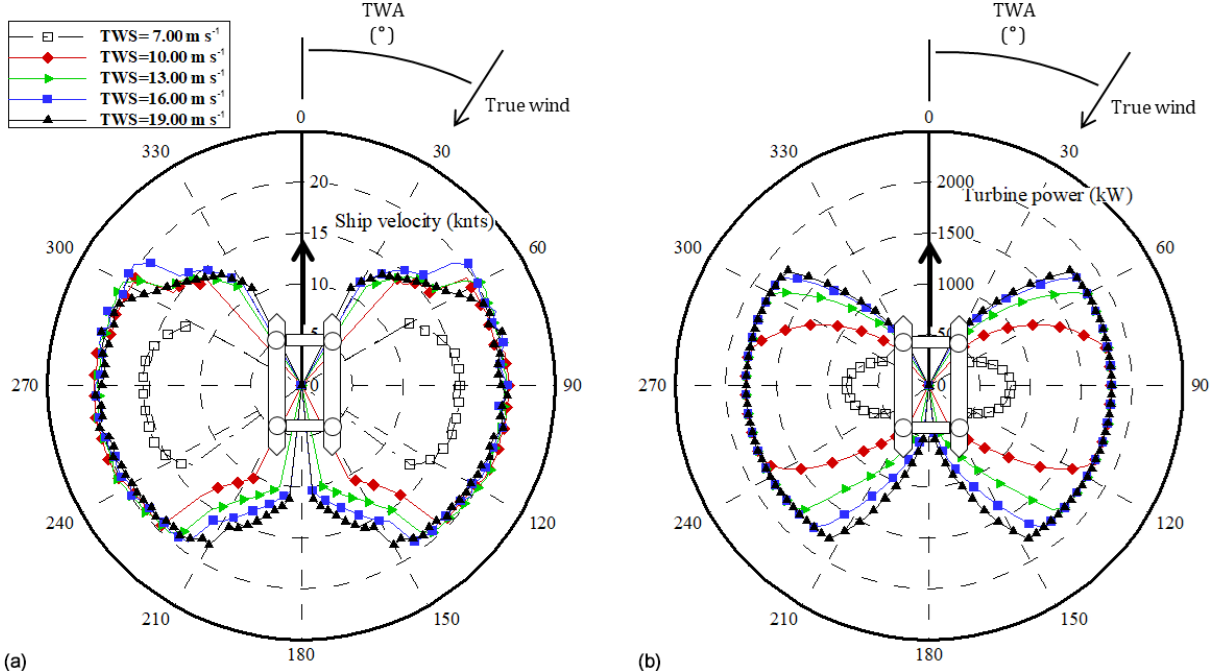
Figure 13. Velocity (a) and generated power (b) polar plots of the proposed energy ship design for true wind speeds of 7, 10, 13, 16 and 19ms − 1 . TWA stands for true wind angle.